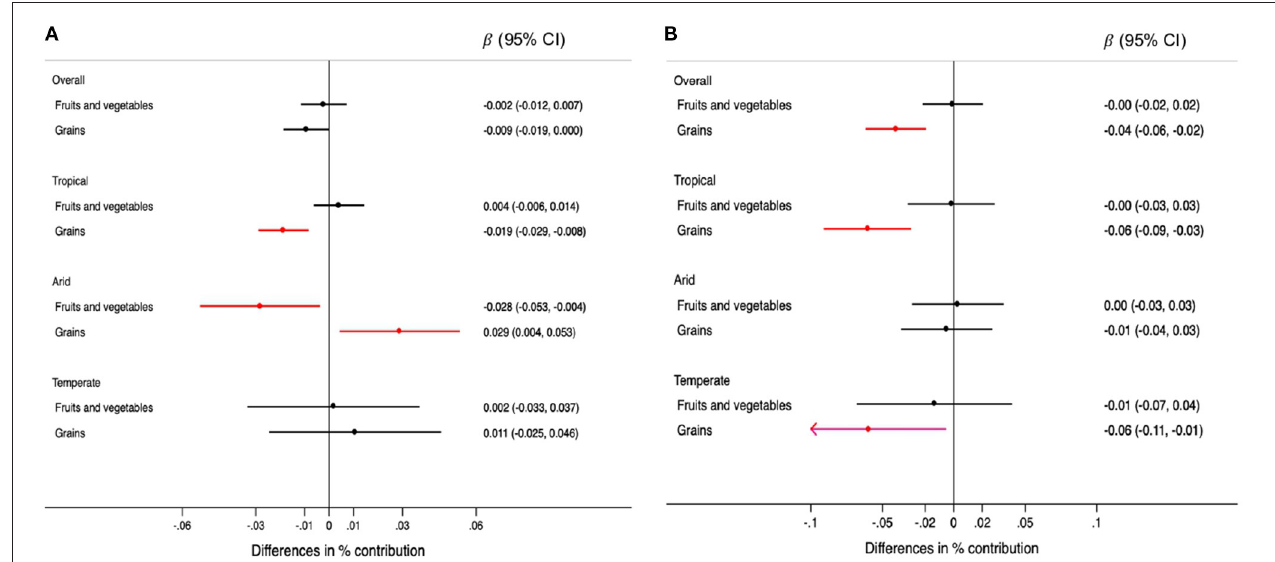
FIGURE 4 | Differences in the percentage (95% CIs) of contribution of types of plant-based foods to the total energy intake for each 0.5mm annual decrease in rainfall (A) and for each 0.1 ◦ C annual increase in temperature (B) during the 5-year period prior to the survey, overall and by climate region. Values were obtained using